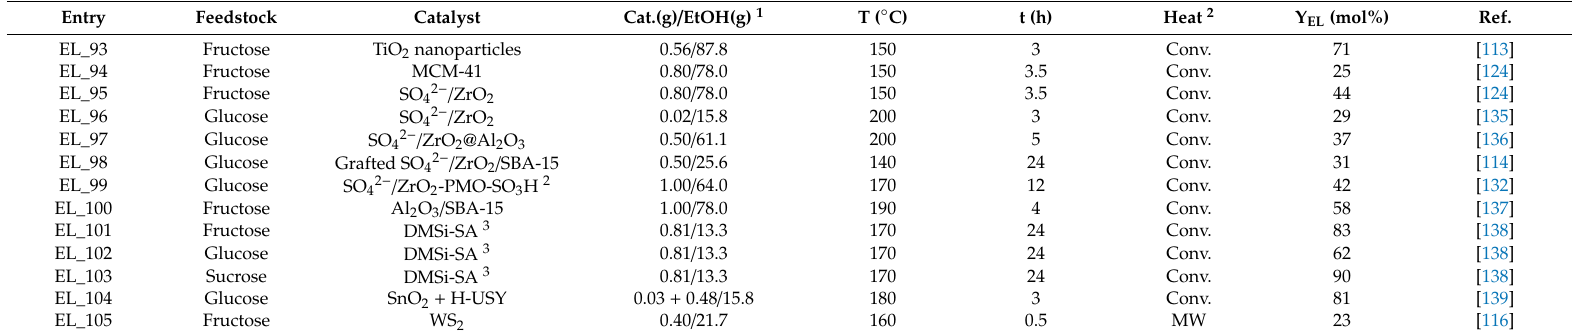
Table 11. Metal oxides and tungsten disulfide catalysts for the EL production from C6 model